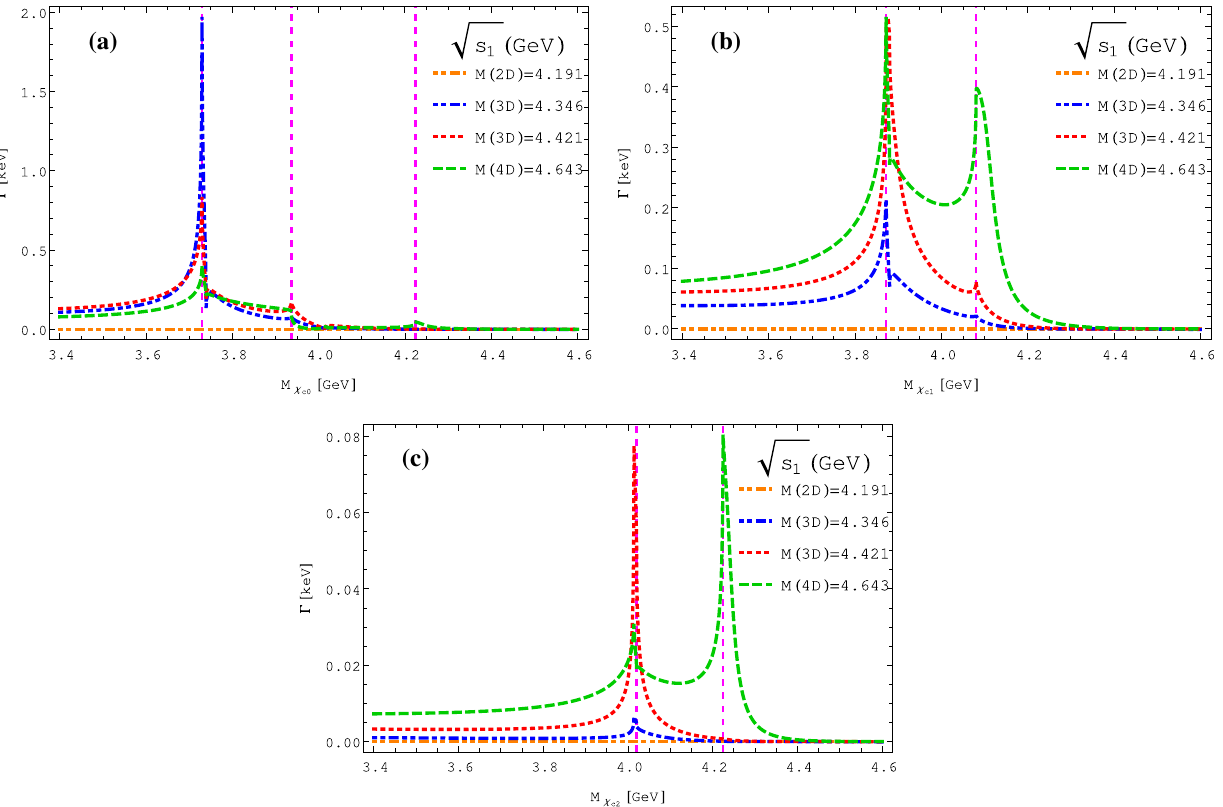
Fig. 5 M χ dependence of the partial widths of ψ( nD ) → γχ cJ . The vertical dashed lines indicted a : D 0 ¯ D 0 threshold, D + s D − s threshold, cJ